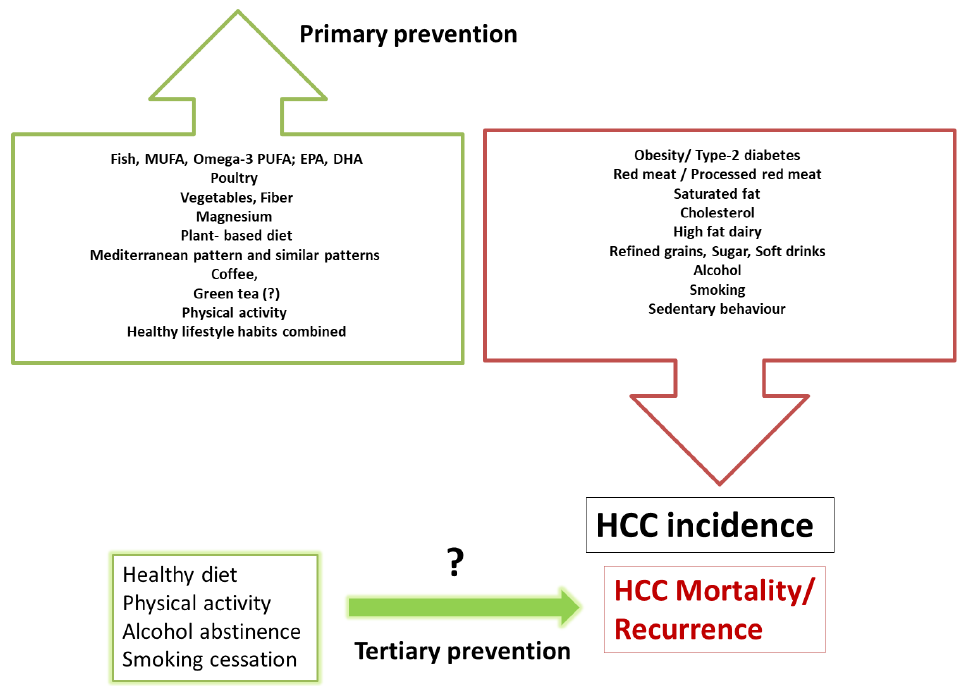
Figure 2. Practical summary for prevention by lifestyle habits; behaviors related with increased risk or reduced risk for HCC incidence and outcomes. The evidence for primary prevention is driven from many prospective cohort studies and seems to be more evidence-based than the scarce evidence for tertiary prevention.